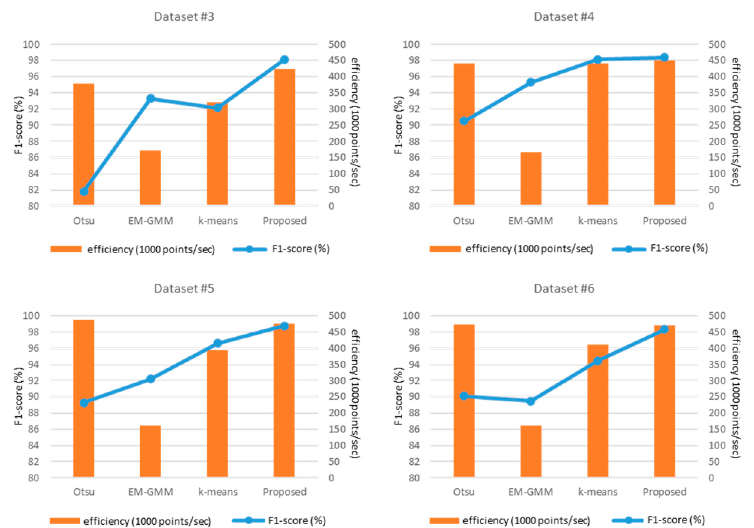
Figure 7. Performance comparison of four segmentation methods (Otsu, EM-GMM, k-means, and the proposed) using Marco datasets # 3, 4, 5, and 6.